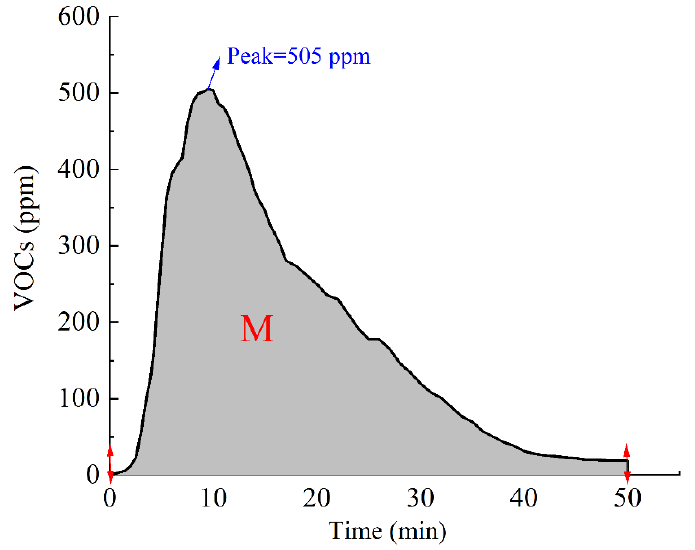
Figure 4. Illustration of VOCs emission M and peak value P.